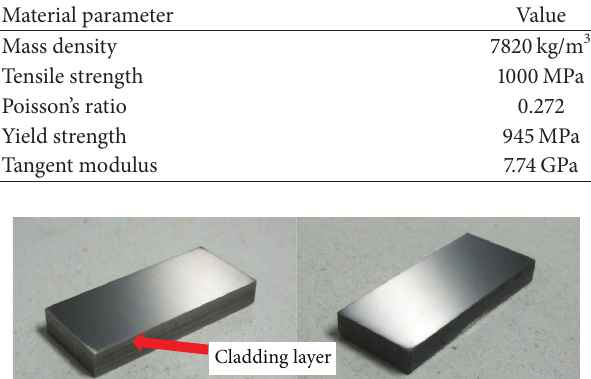
Table 1: Material parameters of solid.